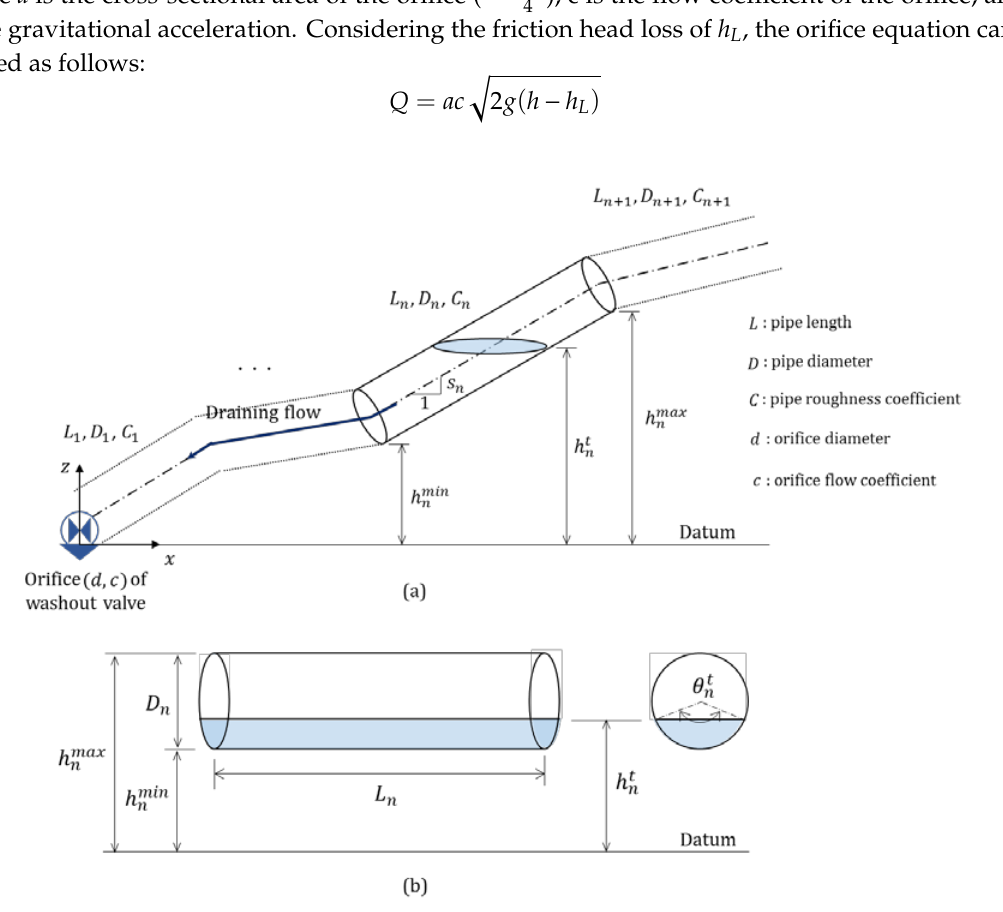
Figure 1. Schematic diagram of pipe drainage: ( a ) a sloped pipe with neighboring ones; ( b ) a horizontal pipe and cross-section.